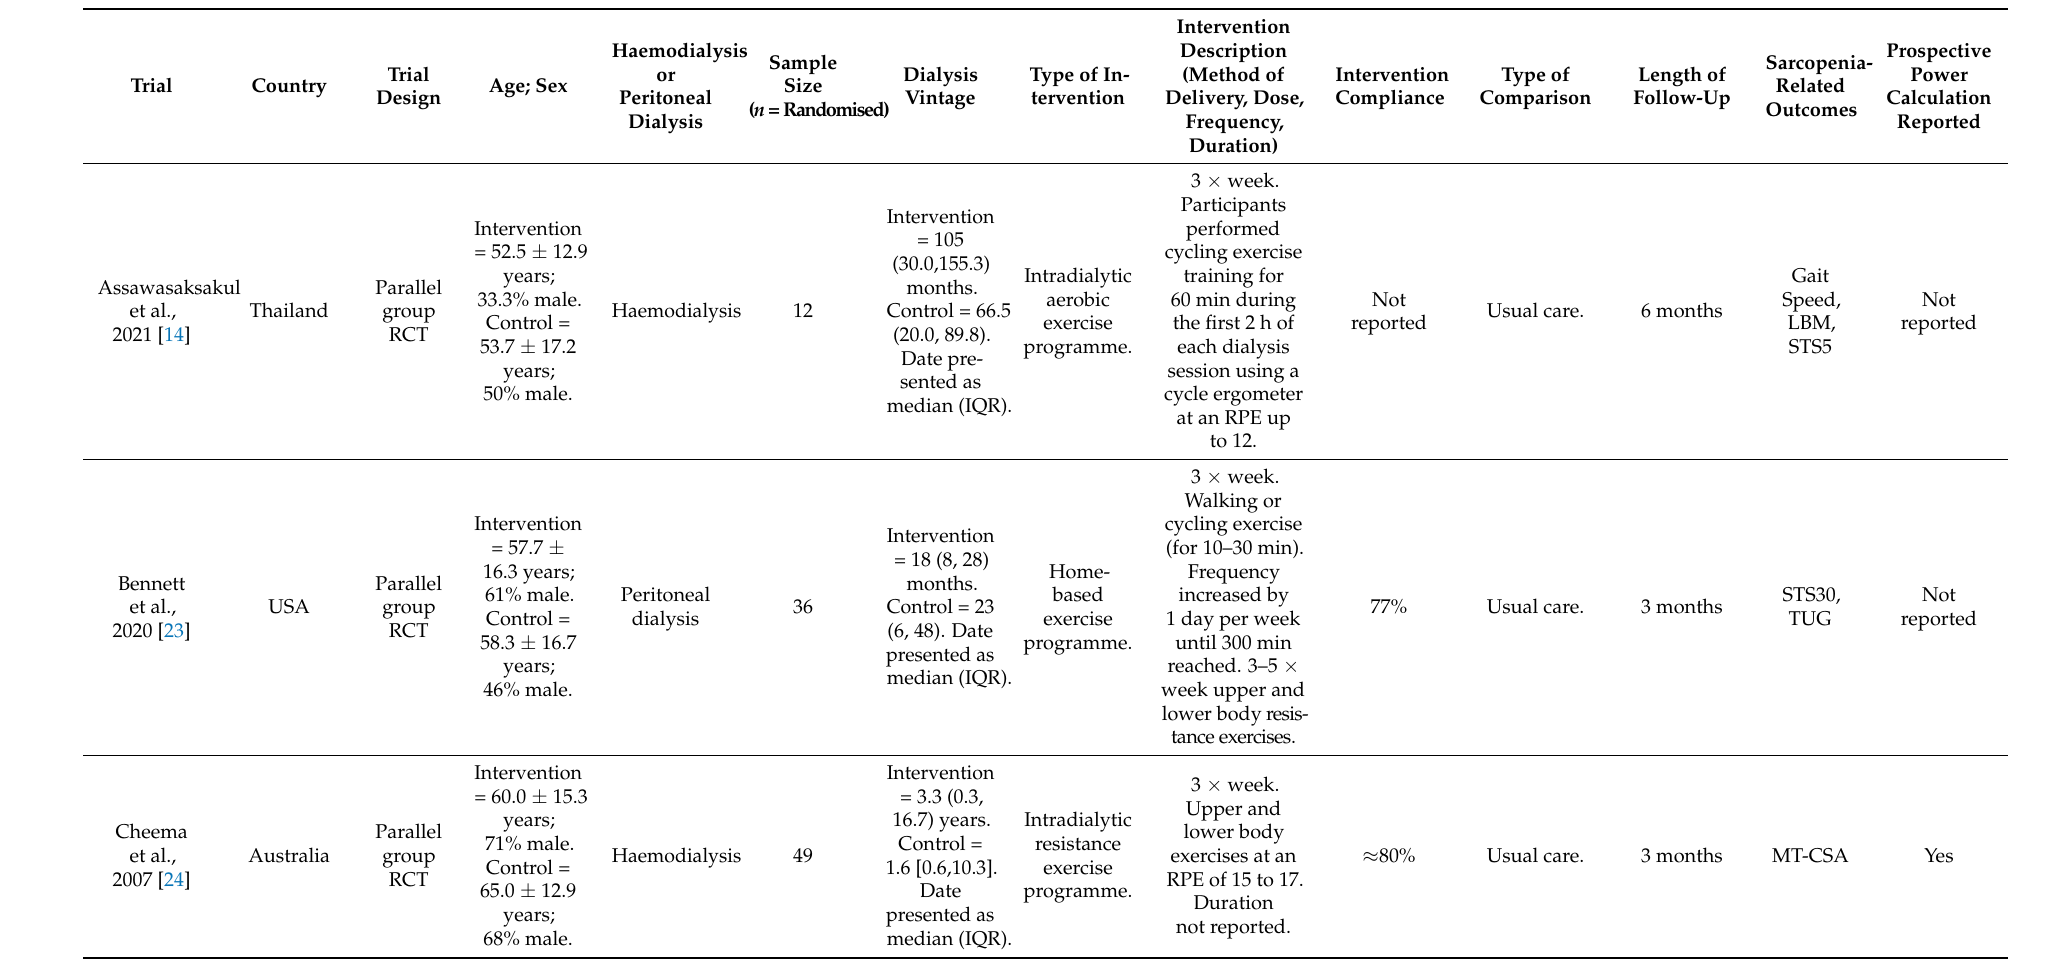
Table 1. Characteristics of exercise trials in the peritoneal dialysis and haemodialysis population that reported an outcome associated with